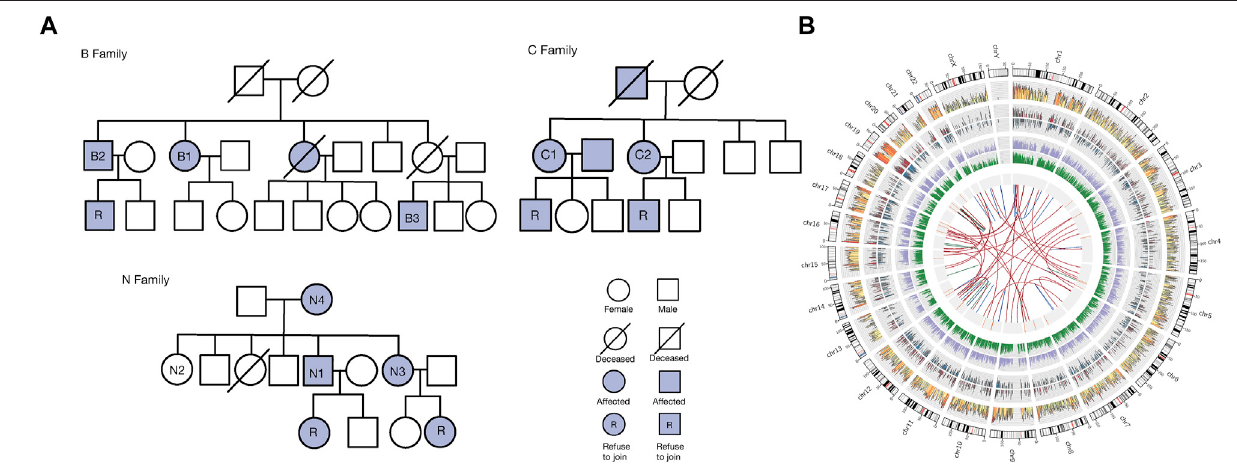
FIGURE 1 | Family information and variants. (A) : Genealogical trees of three Uyghur families with COPD. Square (cid:1) male, and circle (cid:1) female. A square with a slash representsadeadmale,andacirclewithaslashdenotesadeadfemale.AsolidsquarerepresentsamalewithCOPD,andthesolidcircledenotesafemalewithCOPD.A solid square with “ R ” represents a COPD male who refused to join our study, and the solid circle with “ R ” denotes a COPD female who refused to join our study. (B) : Summary of all variations among exomes of family members with COPD. There are nine circles of information represented from the outside to the inside of this. Panel 1. Chromosome. 2. Map of SNVs. The density calculation is based on the number of SNVs in each window using log 10 . The color changes from red, yellow, and blue. 3. Density graph of inserts. The density calculation is based on the number of inserts in each window using log 10 . 4. Density of deletions. The density calculation is basedonthenumberofdeletionsineachwindowusinglog 10 .5.Densitymapofthevariationsitesincodingregions,includingSNVsandInDels.Thedensitycalculationis based on the various sites in each window using log 10 . 6. Density map of the mutation sites in the noncoding area, including SNVs and InDels. The density calculation is basedonthenumberofmutationsites ineach windowusing log 10 .7.MapofCNVlocations.TheareasizerepresentsthesizeofCNV. Red (cid:1) gain,blue (cid:1) loss (whenthe numberofsamples > 1,thereisnocircle).8.MapofSVposition.Theareasizerepresents thesizeofSVs.Orange (cid:1) DEL,green (cid:1) INS.9.AssociationofSVtypediagram. Blue (cid:1) INV, red (cid:1) CTX, green (cid:1) ITX.